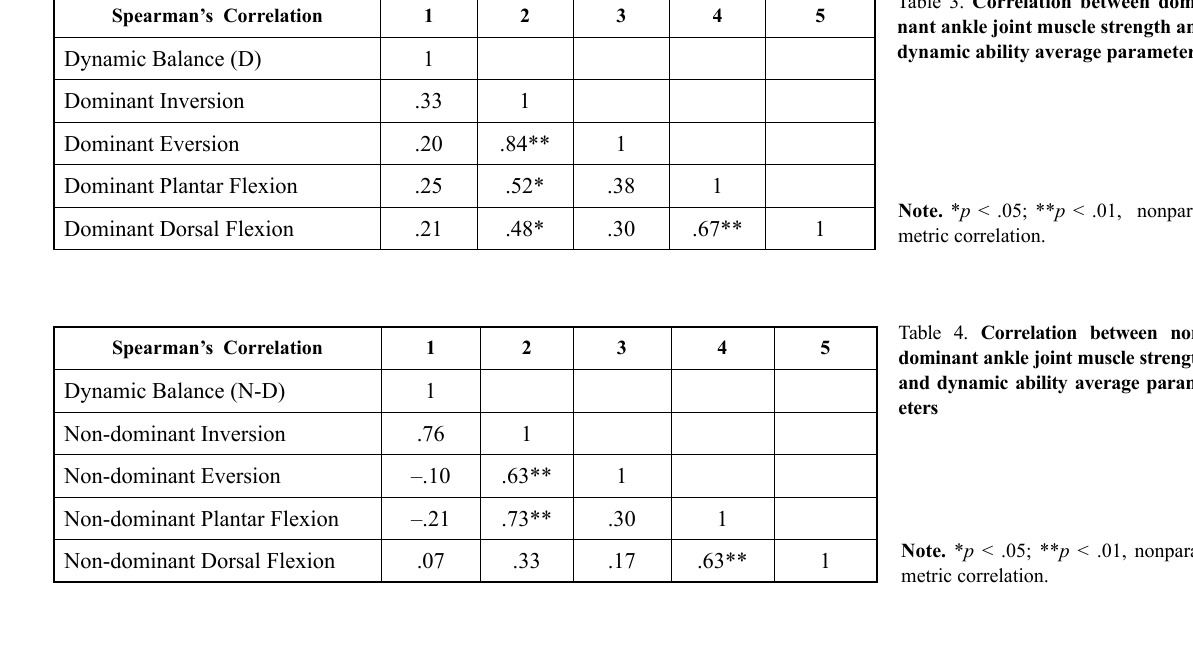
Table 3. Correlation between domi - nant ankle joint muscle strength and